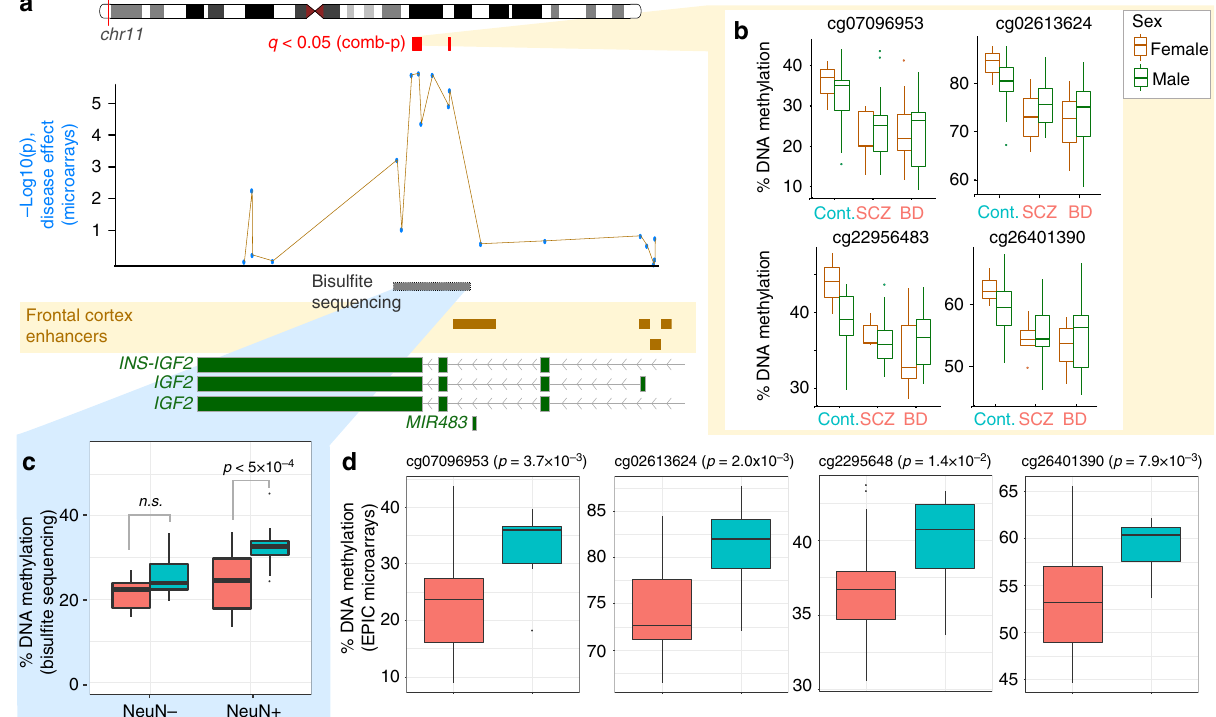
Fig. 2 An enhancer at IGF2 is differentially methylated in neurons of major psychosis patients. a Hypomethylation in psychosis at the IGF2 locus. The view shows differentially methylated regions (red, comb-p) and nominal probe-level p -values (blue) in major psychosis cases ( n = 55 individuals) relative to controls ( n = 27 individuals), as identi fi ed by EPIC arrays. Also shown are adult frontal cortex enhancers (brown rectangles; NIH Roadmap Epigenomics Project) and region validated by targeted bisul fi te sequencing (gray rectangle). b CpG probe-level methylation within differentially methylated IGF2 region, by diagnostic subgroup and sex. Boxplot center indicates median; box bounds indicate 25th and 75th percentile, and whiskers mark 1.5 times the interquartile range. c Validation of IGF2 hypomethylation using targeted bisul fi te sequencing. Average % DNA methylation in a region in IGF2 that is differentially methylated in major psychosis. Box plots show the % DNA methylation averaged over the ~1.3 kb enhancer region in neuronal DNA (NeuN + ; 13 cases, 13 controls) and glial DNA (NeuN-: 10 cases, 12 controls). Bases with ≥ 10× coverage are included in the analysis. P -value from ANOVA for effect of disease, after controlling for age, sex, post-mortem interval, and batch effect. Base-level methylation estimates from EPIC arrays and targeted bisul fi te sequencing